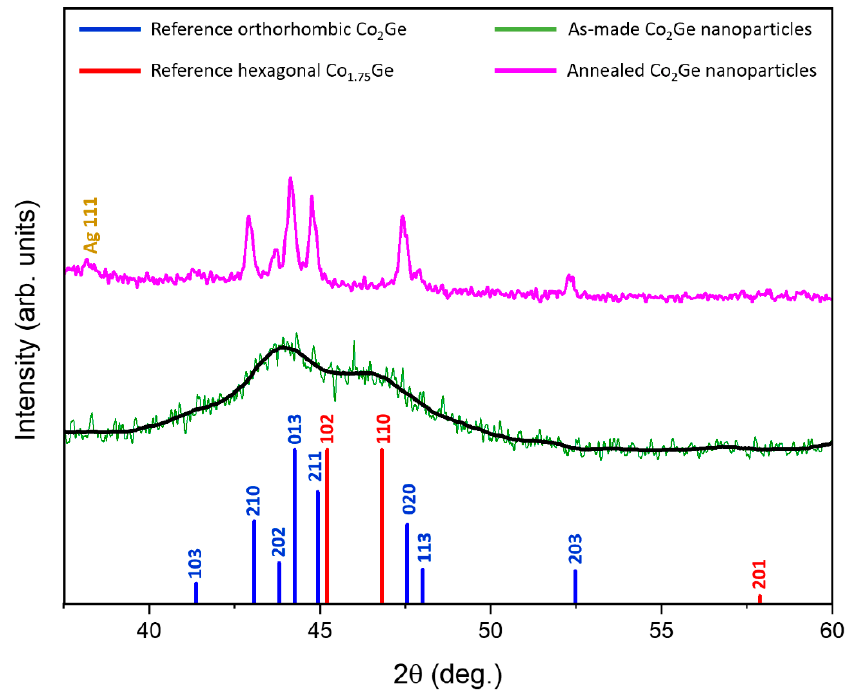
Figure 1. X-ray diffraction (XRD) patterns of the as-made and annealed Co 2 Ge nanoparticles (NPs). The XRD reflections of the orthorhombic phase (OP) are shown with the blue lines [20] and the hexagonal phase (HP) are shown with red lines [21].